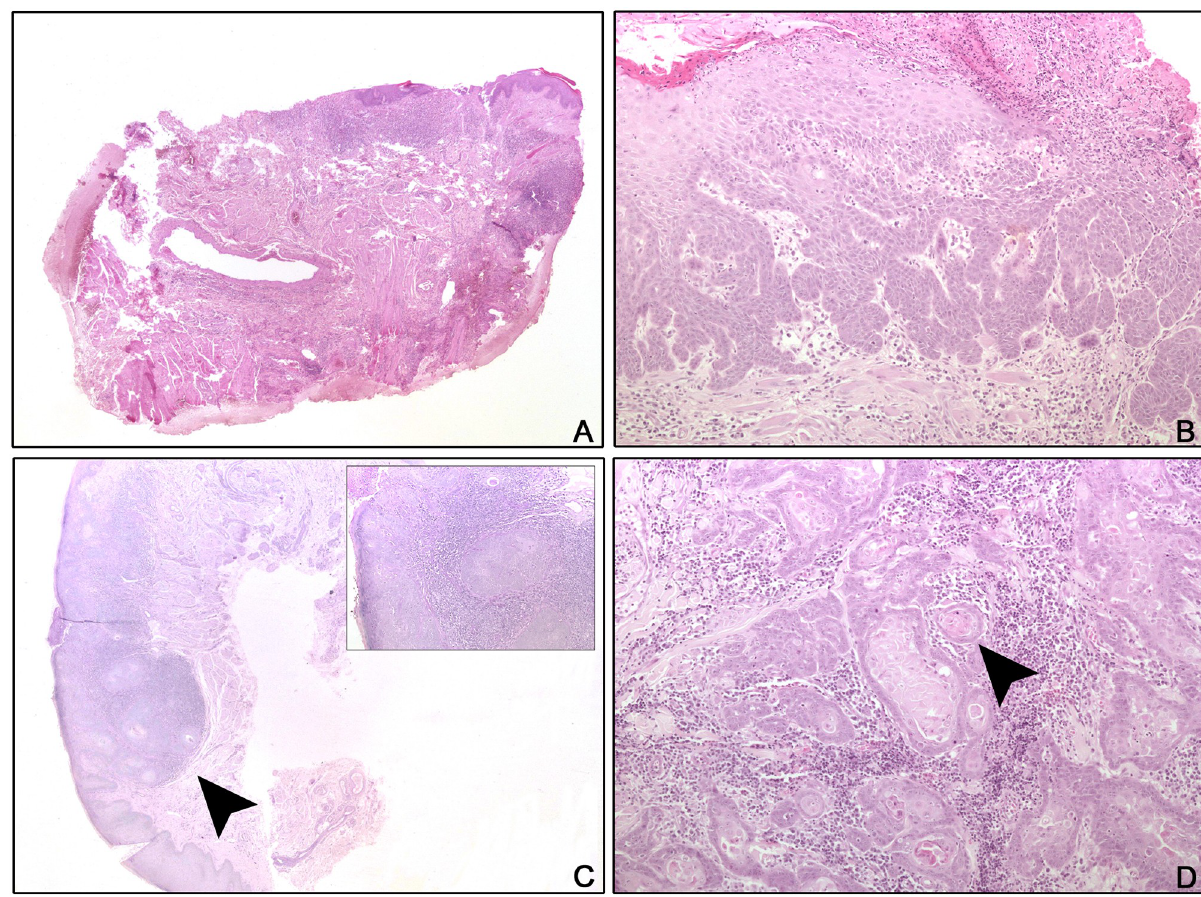
Fig 2. Histology of lip and tongue lesions from sun bears ( Helarctos malayanus ). A: CR036 (2011), Lip, H&E, x2: Chronic ulcerative and mildly hyperplastic cheilitis. B: CR026, Lip, H&E, x10: Epithelial hyperplasia and dysplasia with superficial ulceration and inflammation. C: CR036 (2015), Lip, PAS, x2, inset x10: Islands of neoplastic epithelial cells (arrow head) breach the basement membrane (squamous cell carcinoma) and are associated with chronic inflammation. D: CR080, Tongue, H&E, x10: The tongue is widely effaced by cords, trabeculae, and nests of neoplastic squamoid epithelial cells. Keratin pearls are present (arrow head) and the desmoplastic stroma is inflamed.